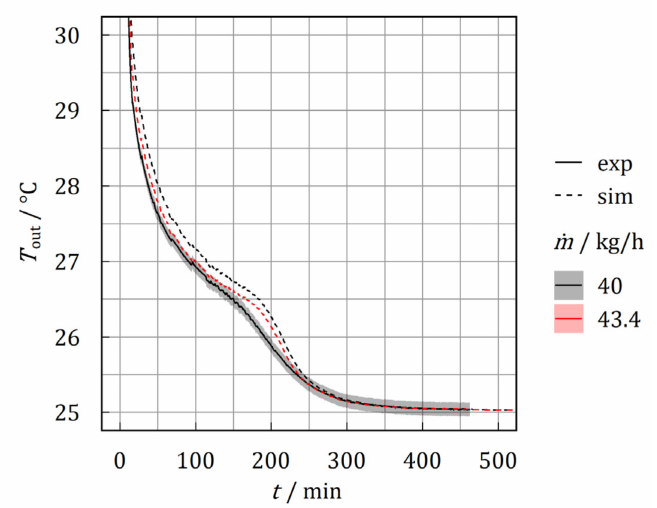
Figure 14. Outlet temperature of the storage of experiment (exp) and simulation (sim) for mass flow rates of 40 and 43.4 kg/h for crystallization. The shaded area around the experimental data shows the uncertainty of the temperature